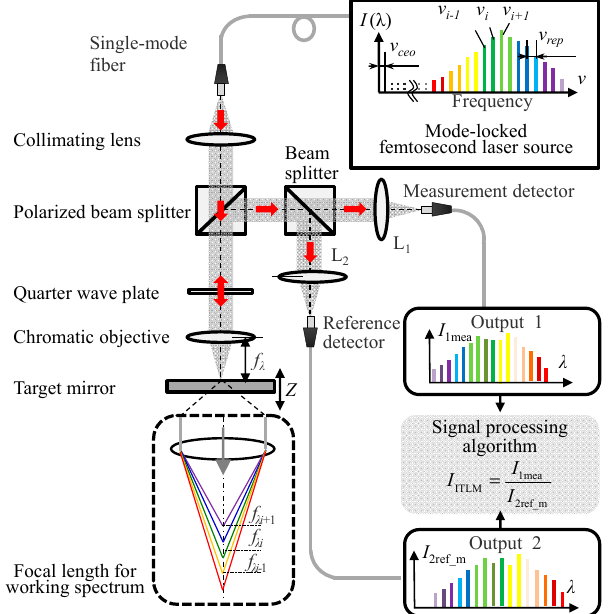
Figure 3. A schematic diagram of the differential chromatic confocal configuration with a mode-locked femtosecond laser source.